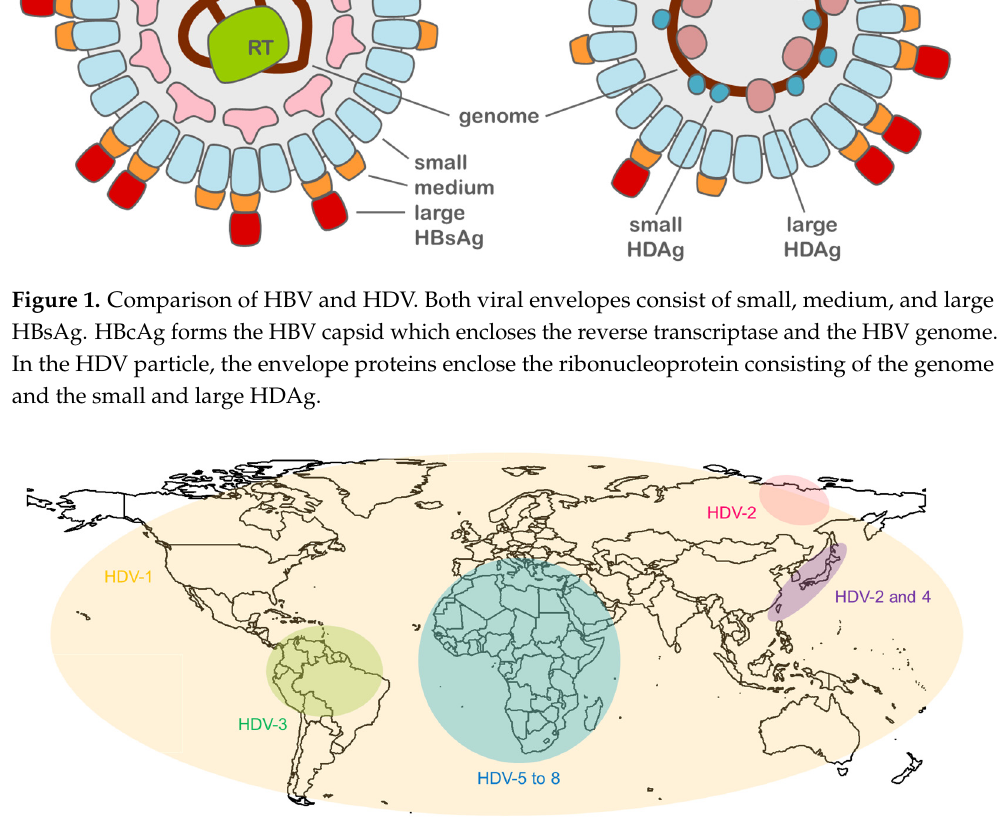
Figure 1. Comparison of HBV and HDV. Both viral envelopes consist of small, medium, and large HBsAg. HBcAg forms the HBV capsid which encloses the reverse transcriptase and the HBV genome. In the HDV particle, the envelope proteins enclose the ribonucleoprotein consisting of the genome and the small and large HDAg.